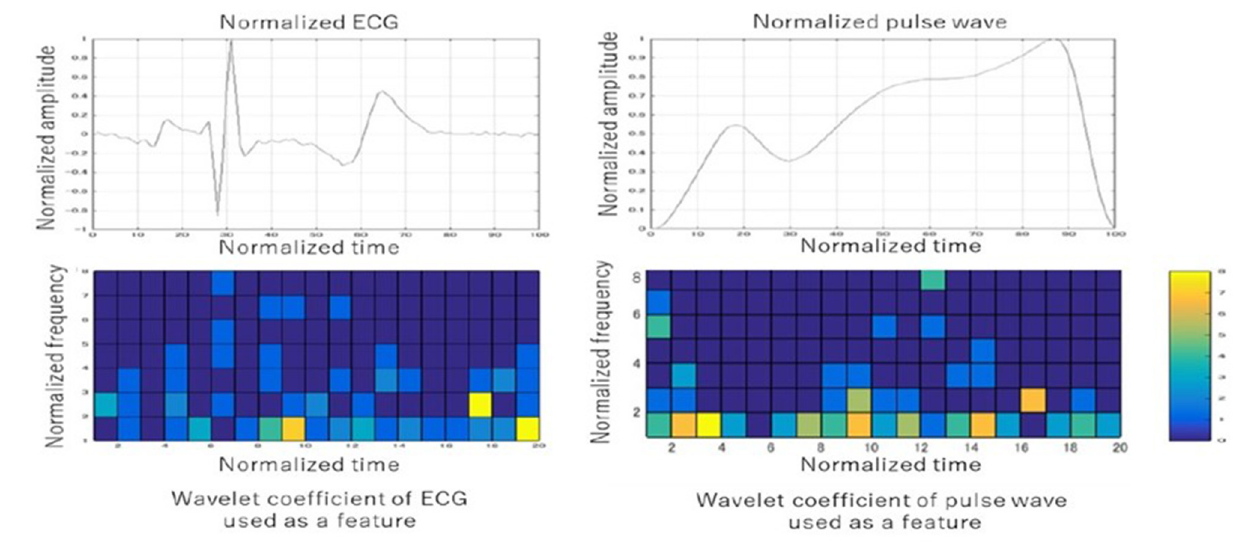
FIGURE 5 | Examples of the wavelet transformation of the ECG and pulse waveforms. The ST-segment and the baseline between the T wave and the P wave had frequently used the wavelet coefficient features in both the wavelet coefficients of the ECG and pulse waveforms.